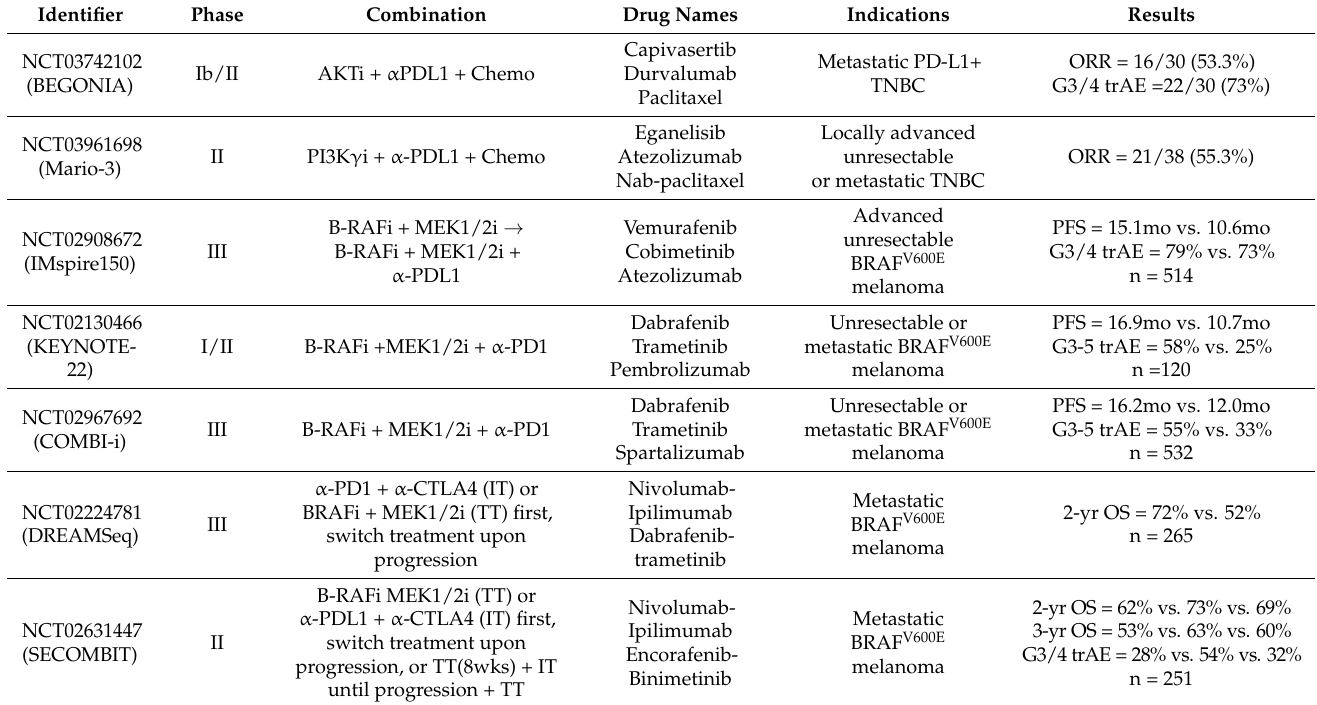
Table 2. Results from clinical trials combining immune checkpoint inhibitors with inhibitors of the PI3K/AKT/mTOR pathway or MAPK pathway in melanoma and